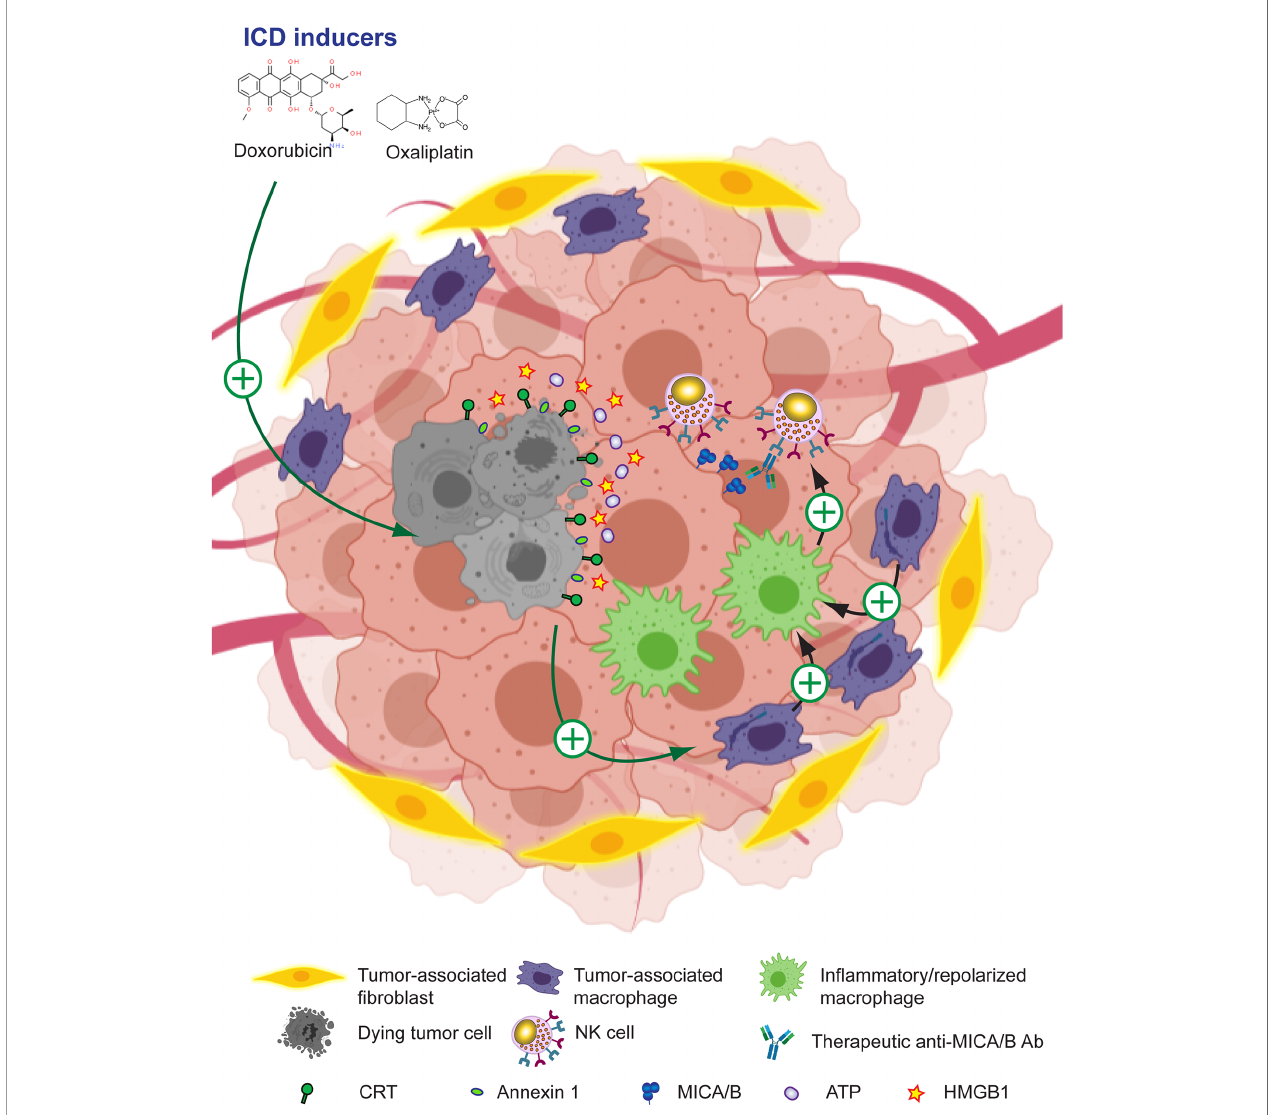
FIGURE 6 | Leveraging anti-MICA/B Ab therapeutic ef fi cacy through combination therapies with ICD inducers. The use of ICD inducers can promote immunogenic tumor cell death with the subsequent expression of CRT and annexin 1 on the tumor cell surface, and the secretion of ATP and alarmins such as HMGB1. Together, these effects result in the remodeling of the TME and a reprogramming of TAM into pro-in fl ammatory macrophages. These pro-in fl ammatory macrophages, instead of inhibiting NK cells, might now promote ef fi cient NK cell effector functions such as improved CD16-dependent ADCC of anti-MICA/B Ab, and a recovery of NKG2D-dependent NK cell-mediated cytotoxicity against tumor cells. Together, these effects may contribute to foster an ef fi cient tumor cell